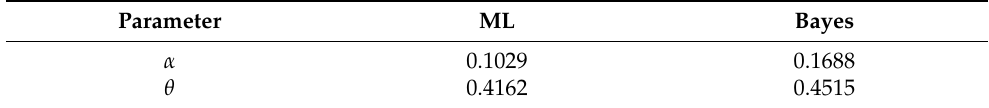
Figure 6. Empirical PP plots of the fitted distributions for the Armenia dataset. The next goal is to use the Bayesian technique to estimate the parameters of the PMiD using the above-mentioned COVID-19 dataset. The analysis was carried out using the MHA of the MCMC technique with 1000 iterations in this perspective. For comparison purposes, both the Bayesian and MLE estimates of the PMiD parameters for the real dataset are given in Table 7. R programming is used to perform the numerical computations. Table 7. MLEs and Bayes estimates of the PMiD parameters on the COVID-19